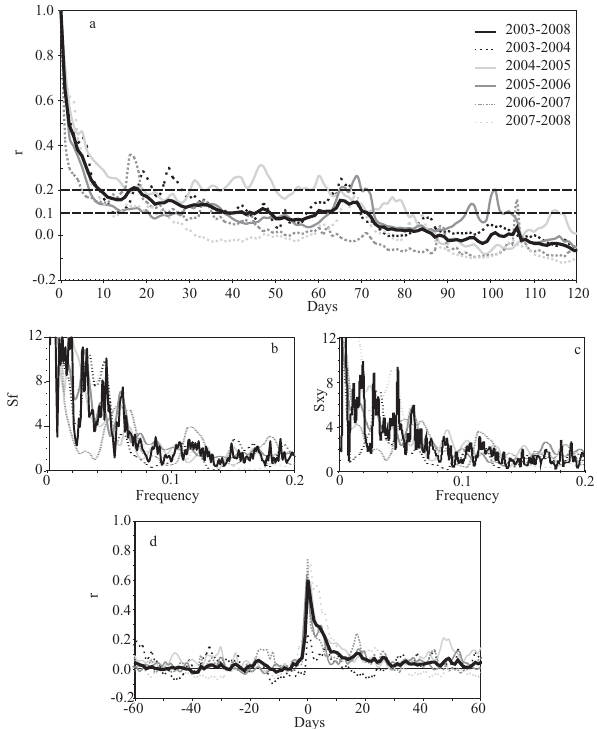
Fig. 4. Time series annual and multiannual analysis of precipitation and discharge daily data registered in Aixola hydrometeorological station from 2003 to 2008. (a) discharge autocorrelogram, (b) discharge simple spectral density function, (c) cross amplitude function, (d)